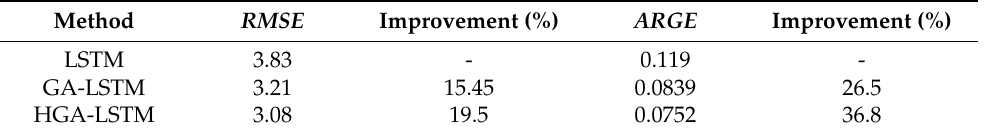
Table 3. Comparison results of LSTM, GA-LSTM, and HGA-LSTM.